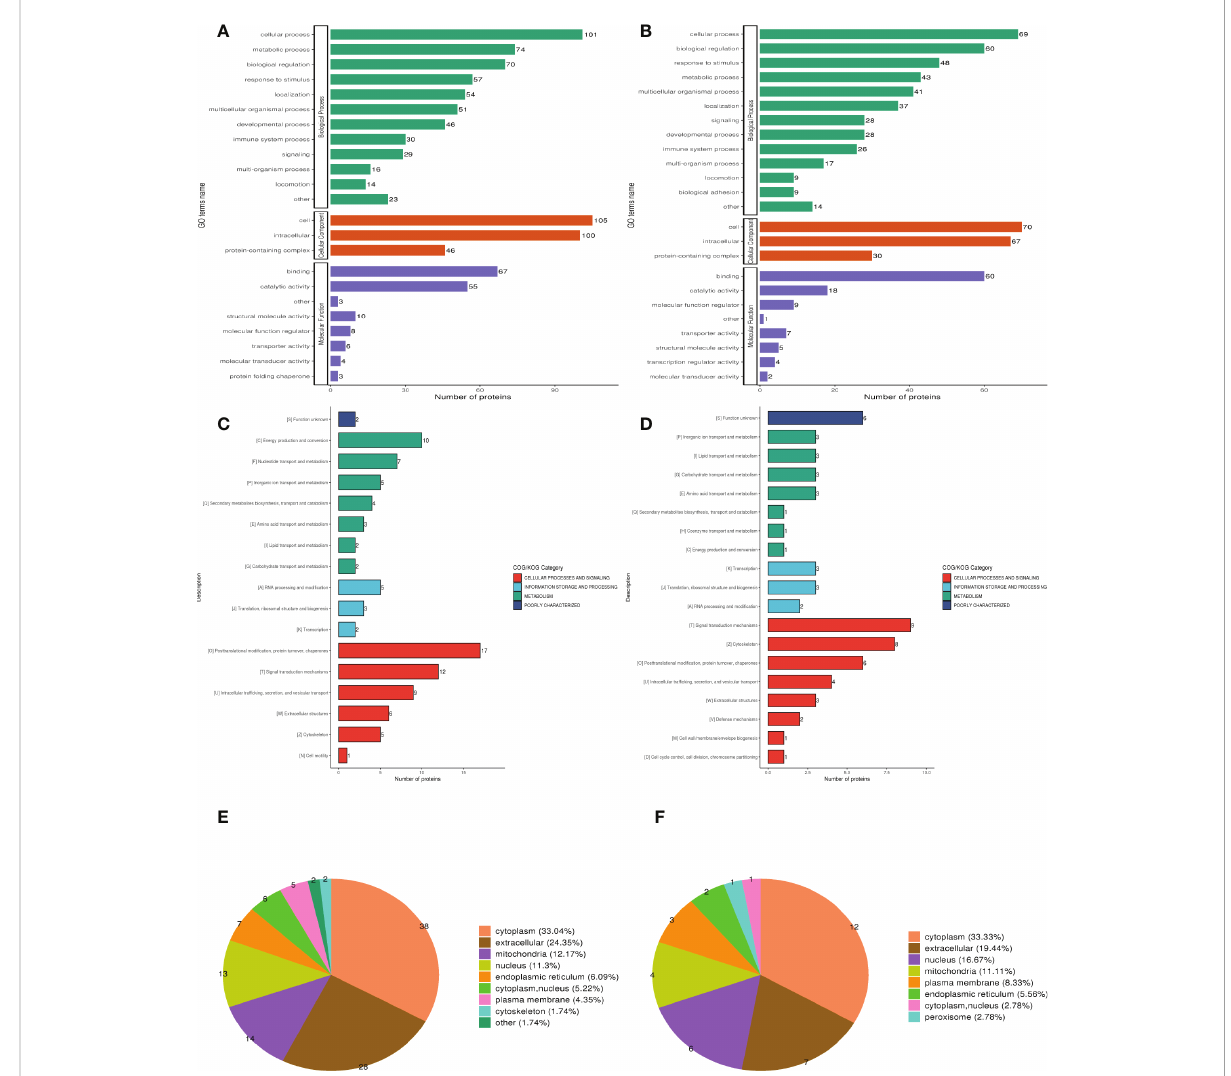
FIGURE 2 Clusters of Orthologous Groups of proteins (COG), Gene ontology (GO), and Subcellular localization annotation for functional classi fi cation. (A, C, E) Were the result of GO, COG, and Subcellular localization of DEPs between group A and group B, while (B, D, F) were the result of that between group B and group D. Different color represents various